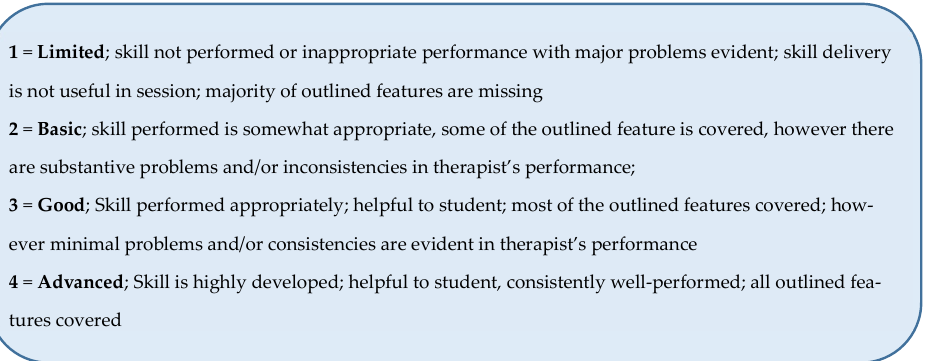
Figure A1. Scoring Legend for Performance band *. * Not applicable is marked if the particular skill is not relevant for the particular session. This is to be used only for treatment specific skills.